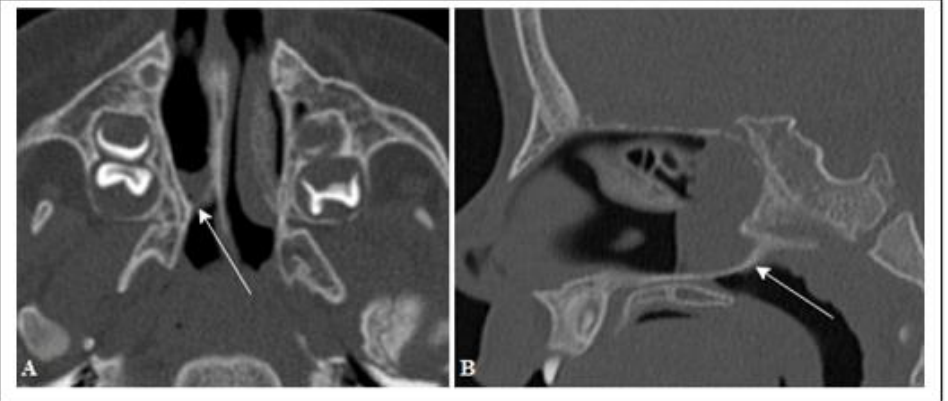
Figure 2. Axial CT scan ( A ), sagittal reconstruction ( B ) of a child with right unilateral choanal atresia. Mixed atresia wall; bone (arrows).